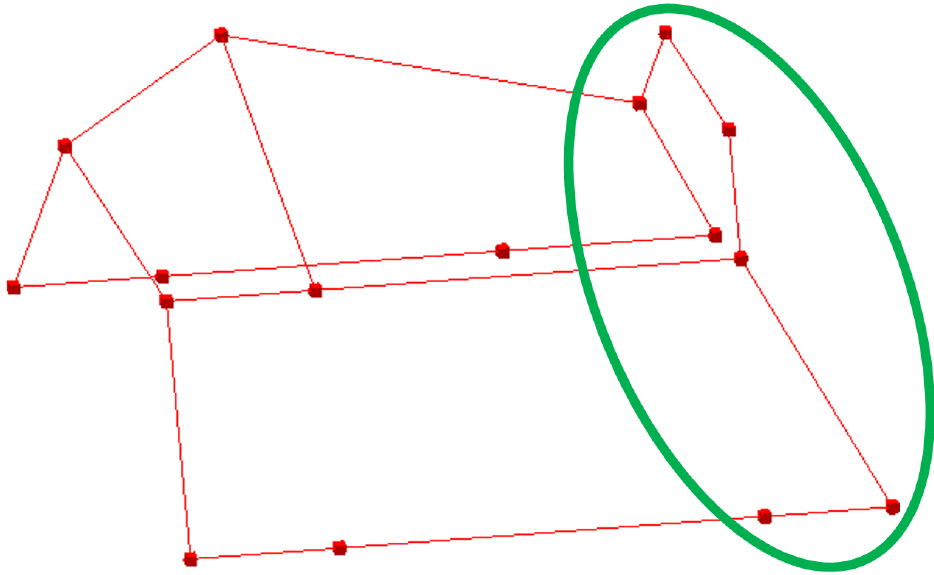
Figure 4. Measurement grid for EMA when stationary. Points encircled with green eclipse are related to the bearing with excessive vibration levels.